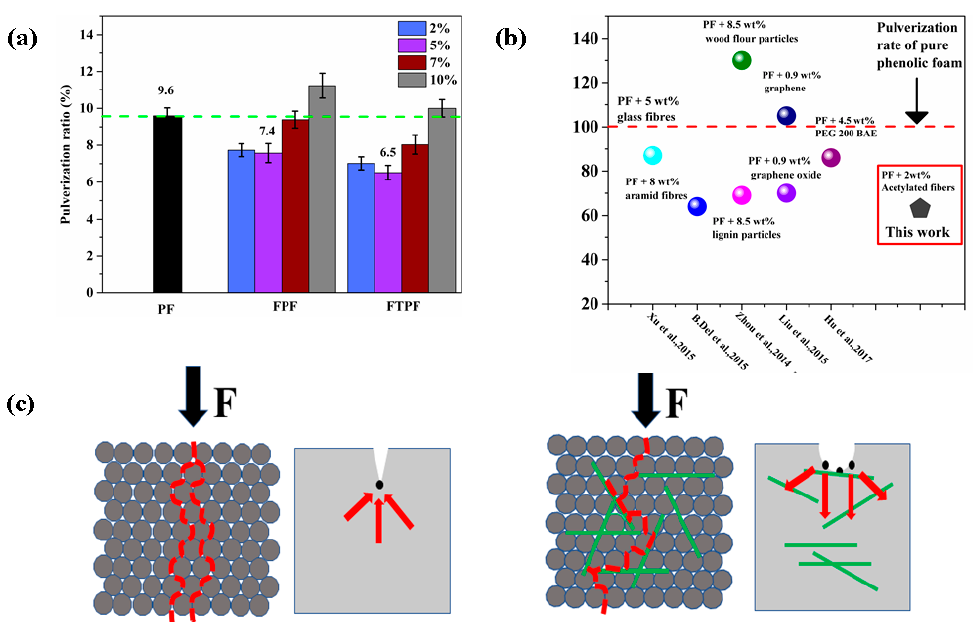
Figure 6. ( a ) Pulverization ratios of the PF, FPFs, and FTPFs. ( b ) Comparison between toughened modified foam resins in the existing literature and the preferred foam resins in the present study [4,12,31–33]. ( c ) Model diagrams of PF and FPF under loading.